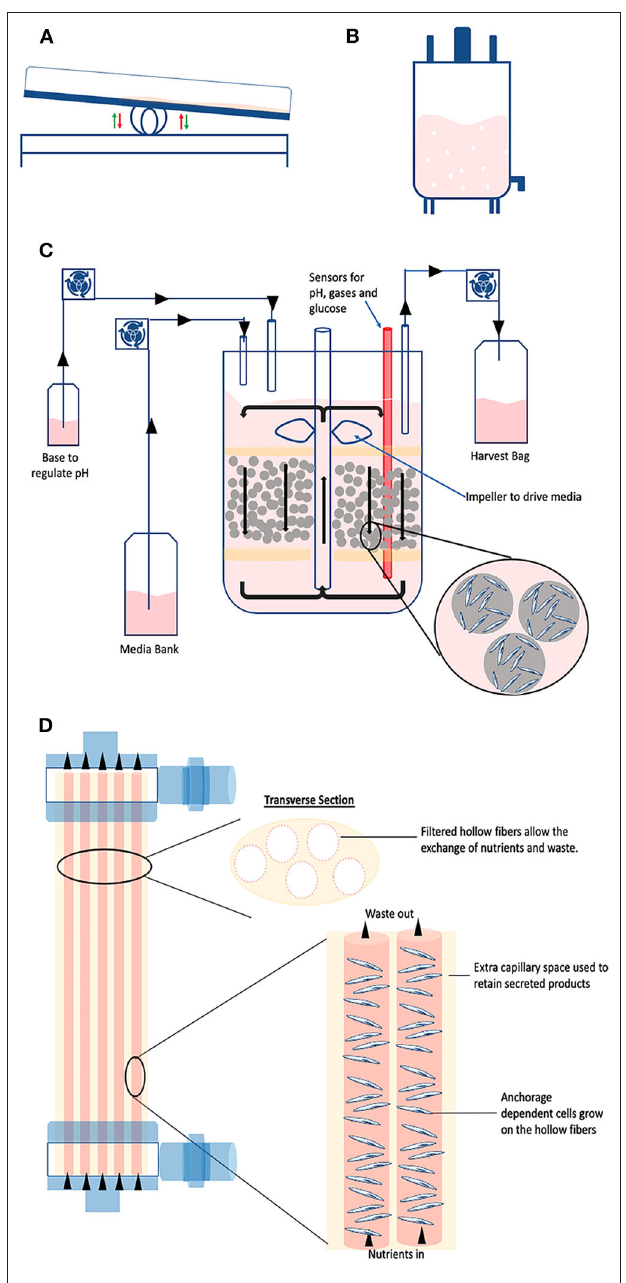
FIGURE 6 | Large scale technologies. Schematic representing the discussed industrial technologies: (A) Wave; (B) Stirred tank; (C) Packed bed; and (D) Hollow fiber